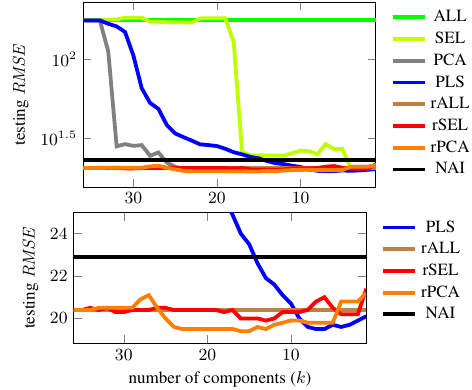
Figure6. Nowcastingerrorasafunctionofcomponentsretained(topplot–allmodelsinlogscale, Fig. 6. Nowcasting error as a function of components retained (top bottomplot–bestmodelszoomedin). Figure 6. Nowcasting error as a function of components retained Fig. 6. Nowcasting error as a function of components retained (top (top plot – all models in log scale; bottom plot – best models plot - all models in log scale, bottom plot - best models zoomed in). plot - all models in log scale, bottom plot - best models zoomed in). zoomed